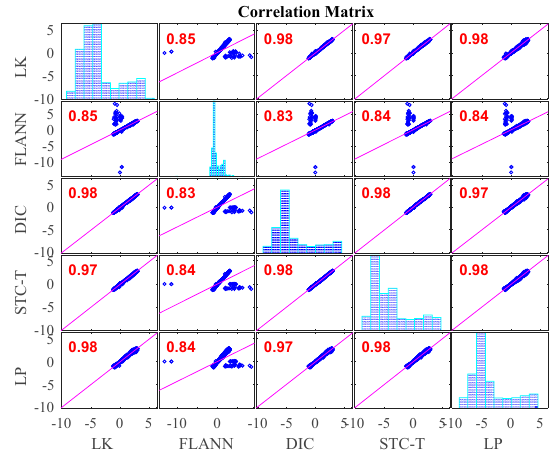
Figure 16. Correlation matrix of time displacement histories of Case 2 (illumination change).